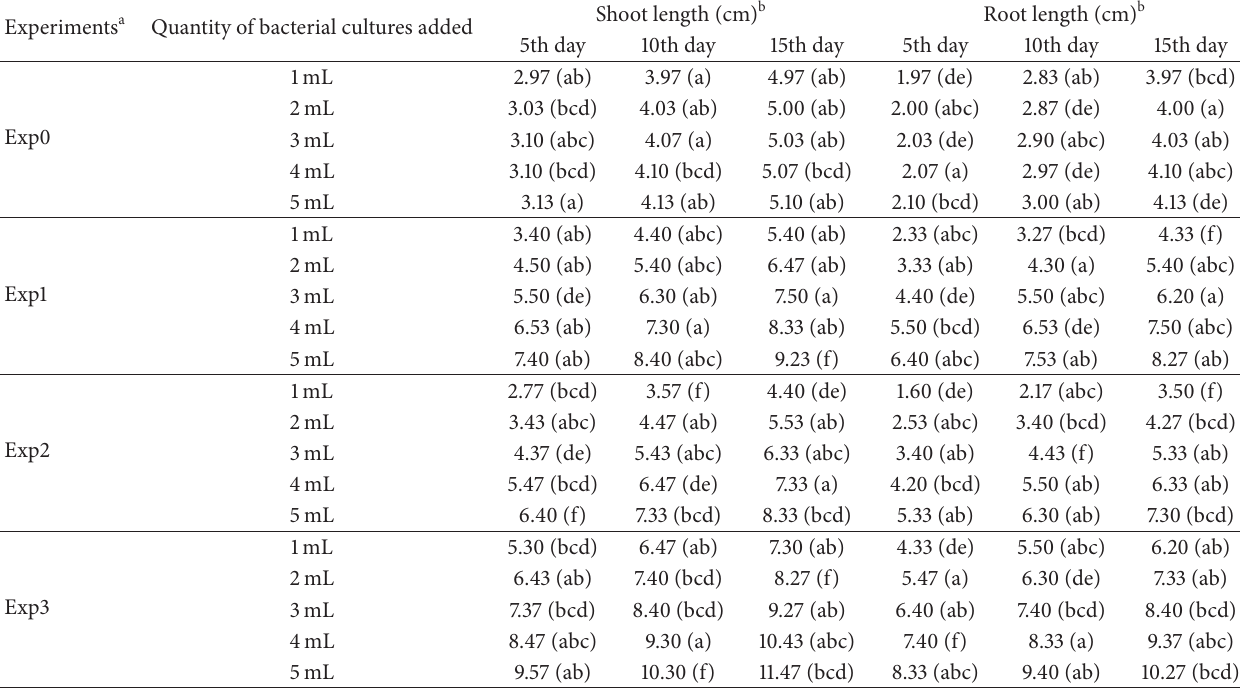
Table 3: Shoot length and Root length of Vigna unguiculata grown on vermiculite supplemented with Bacillus cereus , with Pseudomonas spp., and with their consortium (1: 1) at five different concentrations (1, 2, 3, 4, and 5 mL) on the 5th, the 10th, and the 15th day and in the control. Experiments